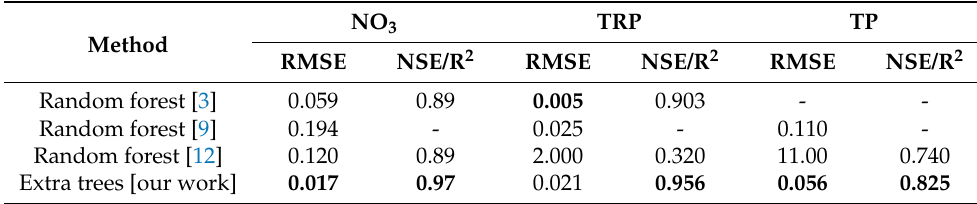
Table 12. A comparative analysis (in terms of the accuracy values reached) of our work and the three most related studies. The predictive performance is not reported where there is a